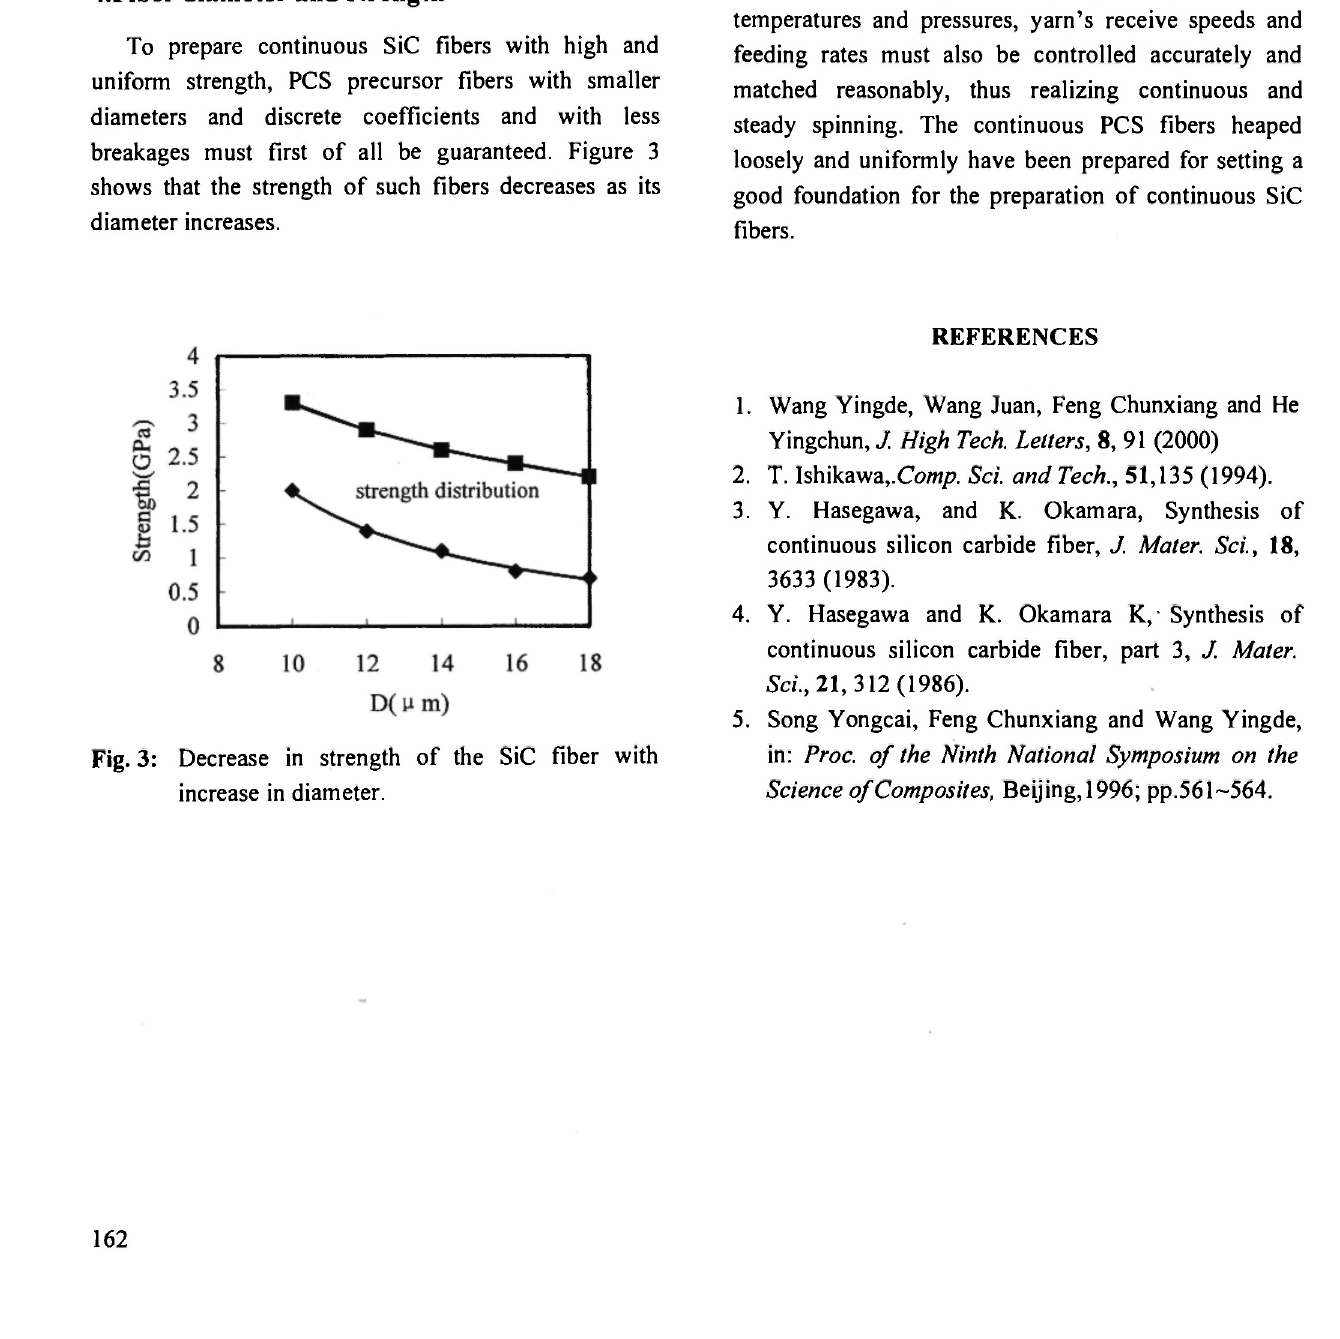
Fig. 3: Decrease in strength of the SiC fiber with increase in